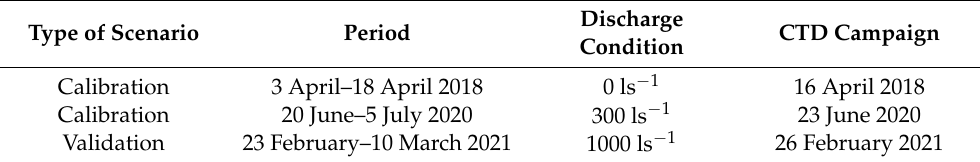
Table 2. Scenarios of numerical modeling